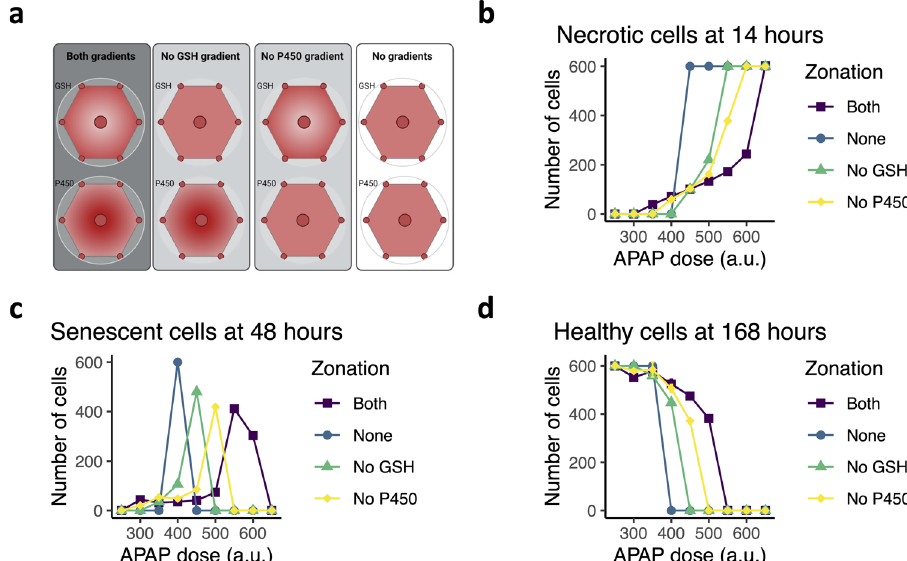
Fig. 3 The effect of zonal expression of GSH and P450 on adverse outcome. a Illustration of four different in silico zonation scenarios. Figure created with BioRender. b – d The dependence of the number of necrotic hepatocytes at 14 h after exposure ( b ), of the number of senescent hepatocytes at 48 h after exposure ( c ), and of the number of necrotic hepatocytes at 168 h (7 days) after exposure ( d ) on applied APAP concentration. Results are based on ten simulations per condition represented as mean ±